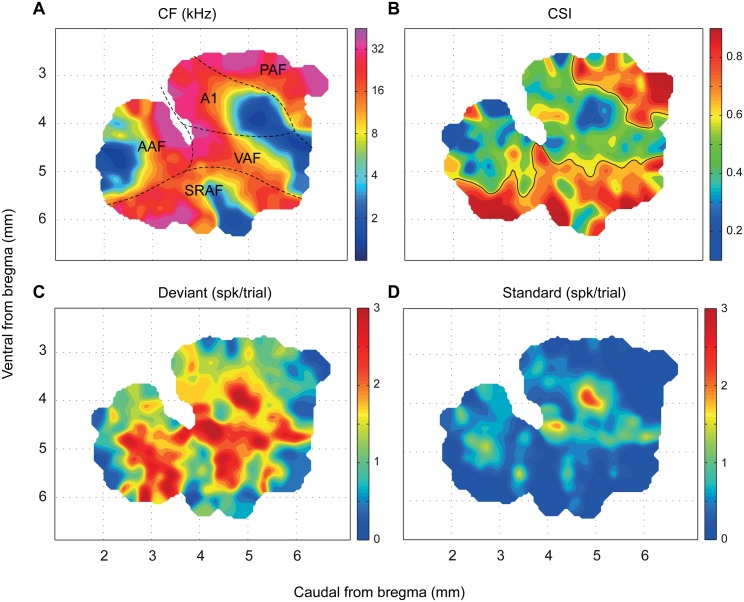
Topographic distribution of SSA throughout the auditory cortex.
A. Synthetic map of the auditory cortex showing the location of the five cortical fields. The CF was used as the main reference to put into register the individual maps from the 12 animals. The high topographical correlation of the CF (see text) confirmed the robustness of the alignment. B. Topographic distribution of SSA in the auditory cortex. The CSI follows a statistically significant topography within the auditory cortex (see text), with the highest values being confined to the nonprimary fields. C,D. Topographic distribution of the responses to deviant and standard tones, respectively, from which the CSI was computed. Responses to standard tones were almost zero in the nonprimary fields. Data underlying these maps can be found in S3 Data.